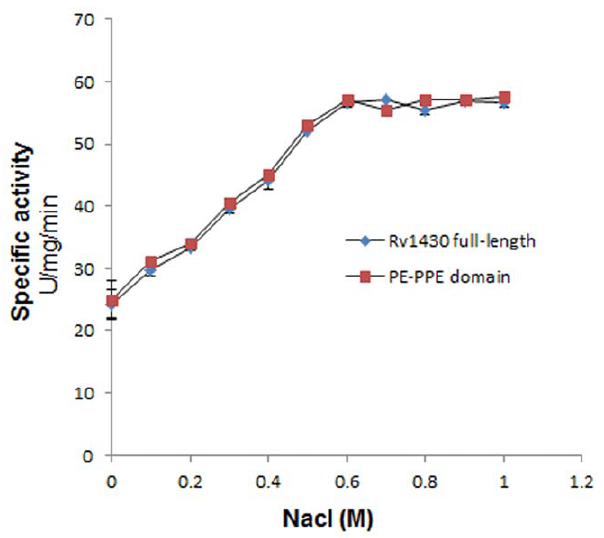
Figure 7. Effect of PMSF on the hydrolysis of pNPC6 by Rv1430 and PE-PPE domain.